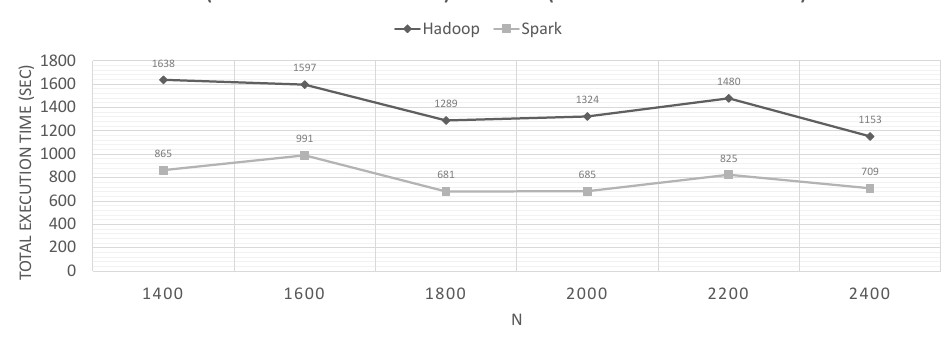
Figure 23. Hadoop vs. Spark, large synthetic query and small training datasets.